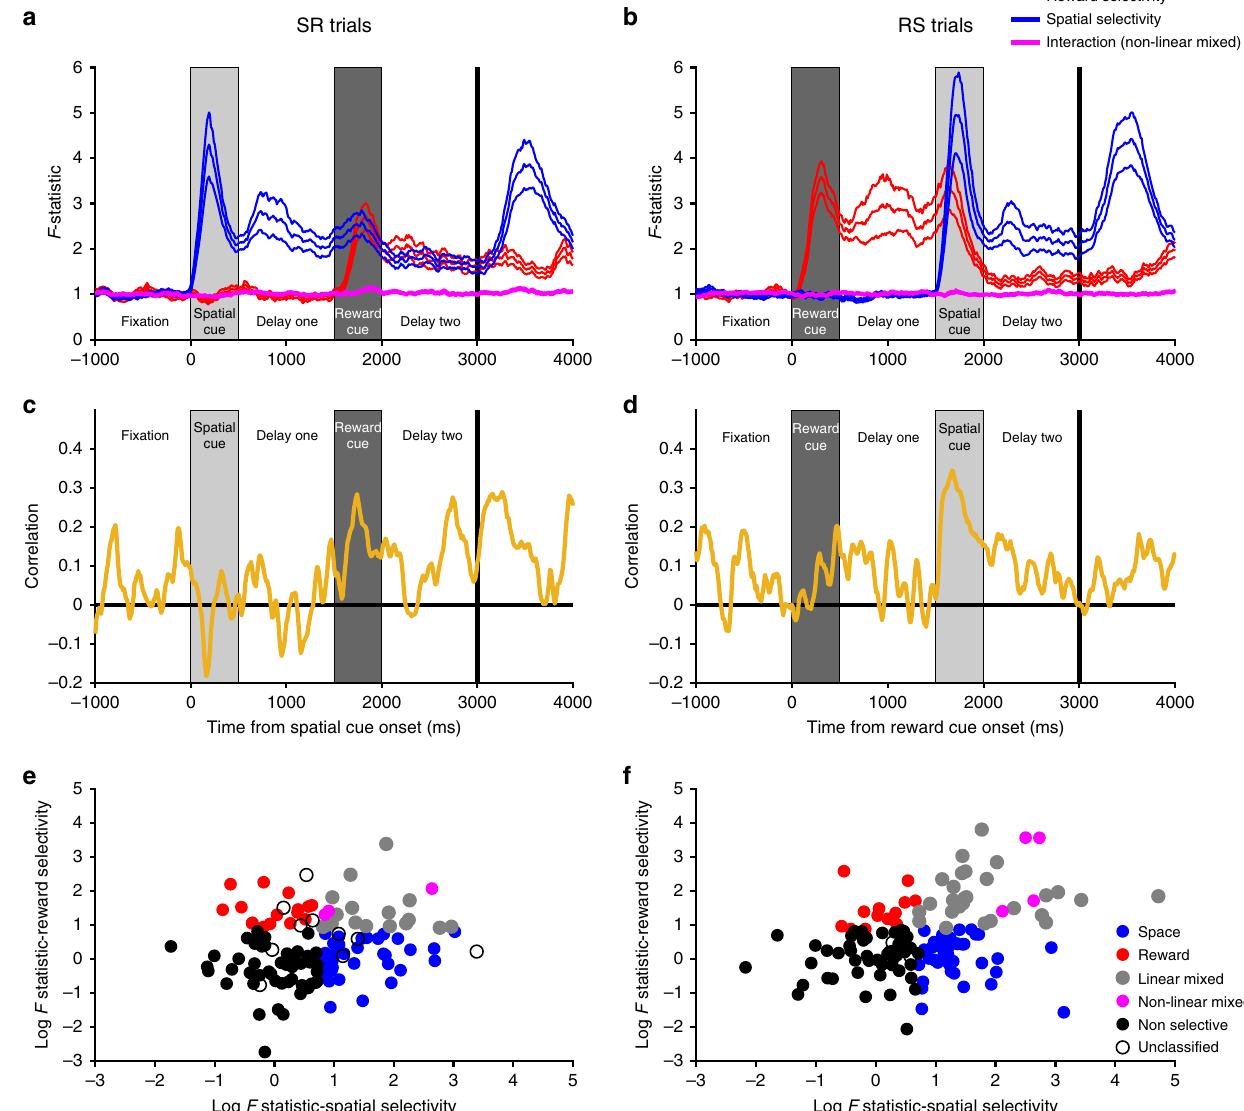
Fig. 8 Absence of non-linear interactions between reward and spatial selectivity. a – b The mean population F -statistics from a sliding two-way ANOVA with an interaction term are plotted (±standard error of the mean) for SR ( a ) and RS ( b ) trials. The interaction term between both factors does not change from that during pre-trial fi xation. c – d Sliding spearman correlation between reward and spatial selectivity F -statistics for SR ( c ) and RS ( d ) trials. On both trial types, there is a positive correlation at the time of cue two, indicating linear mixed selectivity. e – f Spearman correlation of spatial and reward coding F - statistics during cue two for ( e ) SR-trials; ( f ) RS-trials. To complement the above analysis, we performed a single spearman correlation between the raw F - statistics from a 2-way ANOVA of spike-counts during the entire cue two period. There was a signi fi cant positive correlation on SR-trials ( r = 0.175, p = 0.0394) and RS-trials ( r = 0.311, p = 2.08 × 10 − 4 ). Each dot represents a neuron appropriately coloured. Space and reward neurons were required to have only one signi fi cant main effect ( p < 0.05) and a non-signi fi cant interaction ( p > 0.05). Linear mixed neurons were required to have two signi fi cant main effects ( p < 0.05) and a non-signi fi cant interaction ( p > 0.05). Non-linear mixed neurons were required to have two signi fi cant main effects ( p < 0.05) and a signi fi cant interaction ( p < 0.05). Non-selective neurons had no signi fi cant effects ( p > 0.05). A very small number of neurons did not meet these criteria so were unclassi fi ed. F -statistics have been log-transformed for illustrative